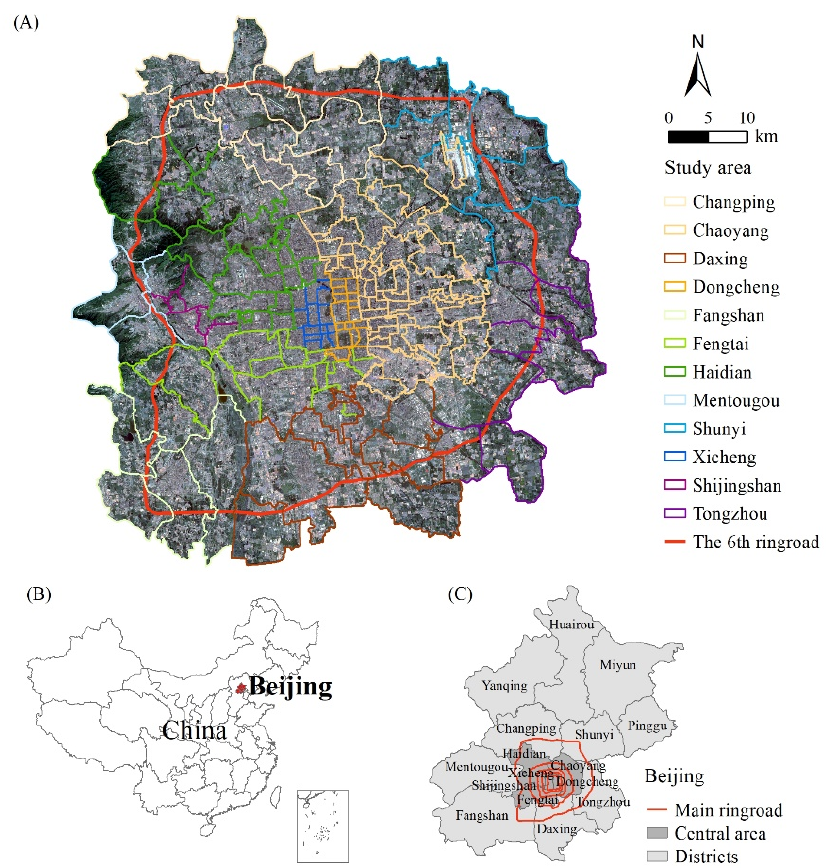
Figure 1. Study area of the sub-districts within Sixth Ring Road in Beijing ( A ), the location of Beijing in China ( B ), and the districts of Beijing ( C ).